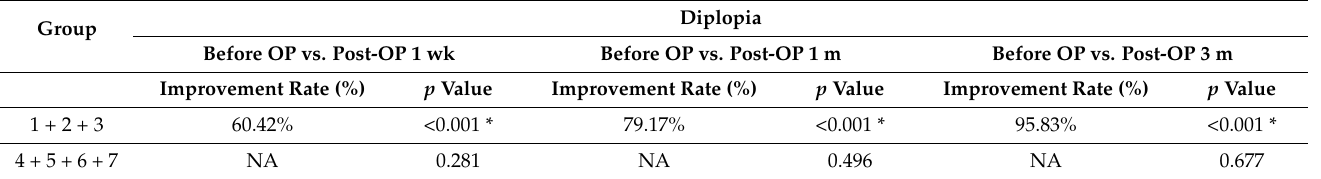
Figure 3. Comparison of diplopia between groups that received surgery within one week (1, 2, 3) and after more than one week (4, 5, 6, 7). The Mann–Whitney U test was used to compare between group (1 + 2 + 3) and group (4 + 5 + 6 + 7); OP, operation; * p < 0.05. Table 4. The relationship of diplopia before and after the operation.